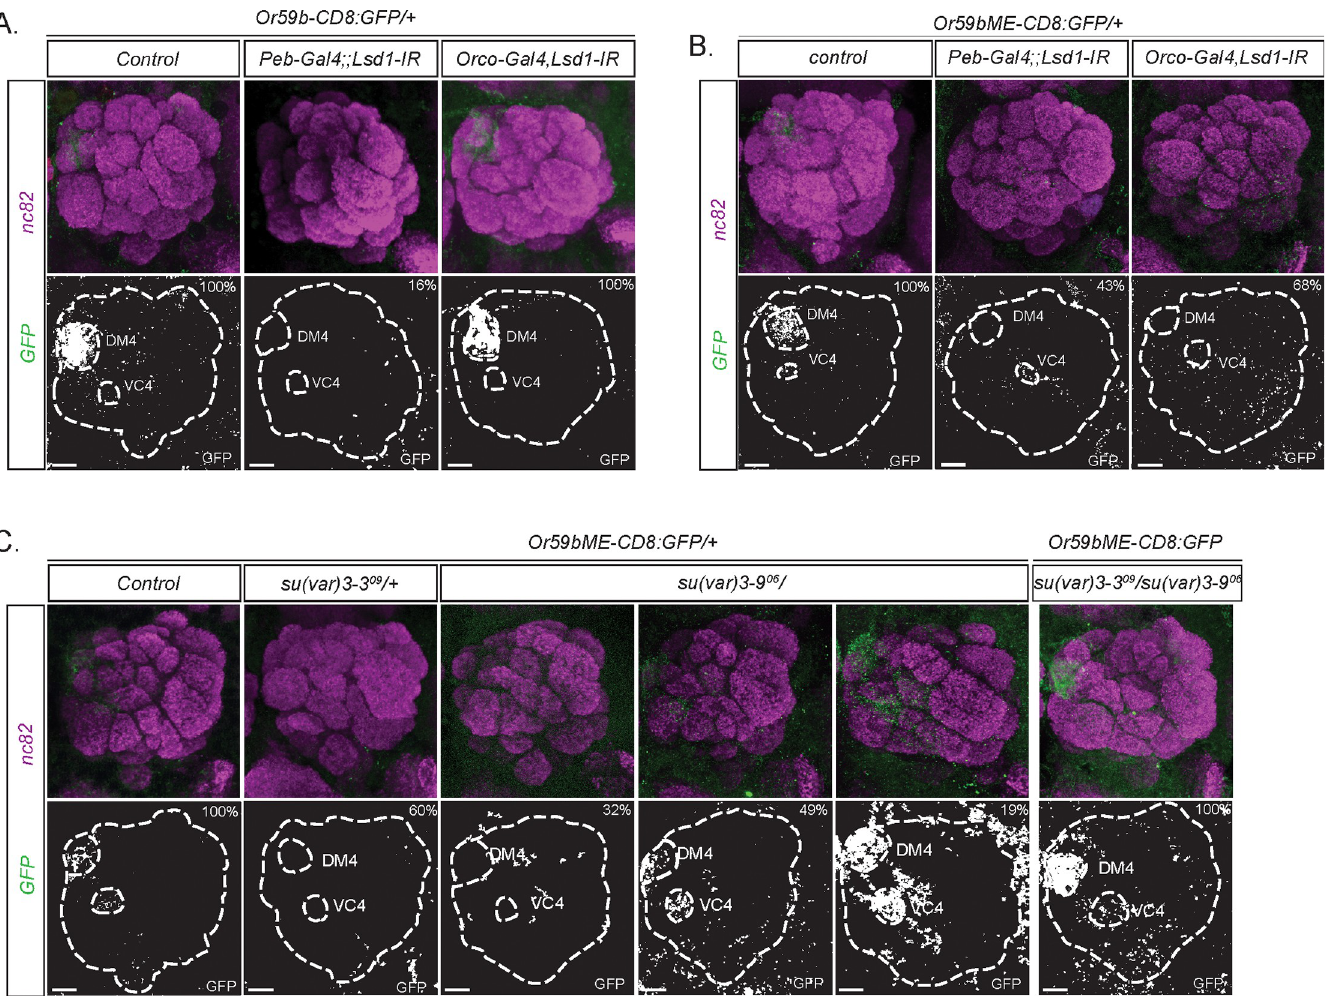
Fig 4. dLsd1 balances Su(var)3-9 and establishes Or59b expression. (A) Or59b reporter and (B) Or59bME reporter GFP expression in flies with dLsd1 knock-down before initiation ( Peb-Gal4 ) or after odorant receptor expression ( Orco-Gal4 ). GFP expression is shown in green. Synaptic neuropil regions are labeled with the presynaptic marker nc82 (magenta). (C) Or59bME reporter expression in heterozygote Su(var)3−9 06 , heterozygote dLsd1 09 , and double heterozygote flies. Note that the expression changes of the Or59bME reporter in single heterozygote flies were rescued in Su(var)3−9 06 and dLsd1 09 heterozygote flies. Control flies were crossed to w 1118 . Percentage denotes the fraction of flies with the depicted phenotype (S2 Data). Scale bar denotes 3.5 μ